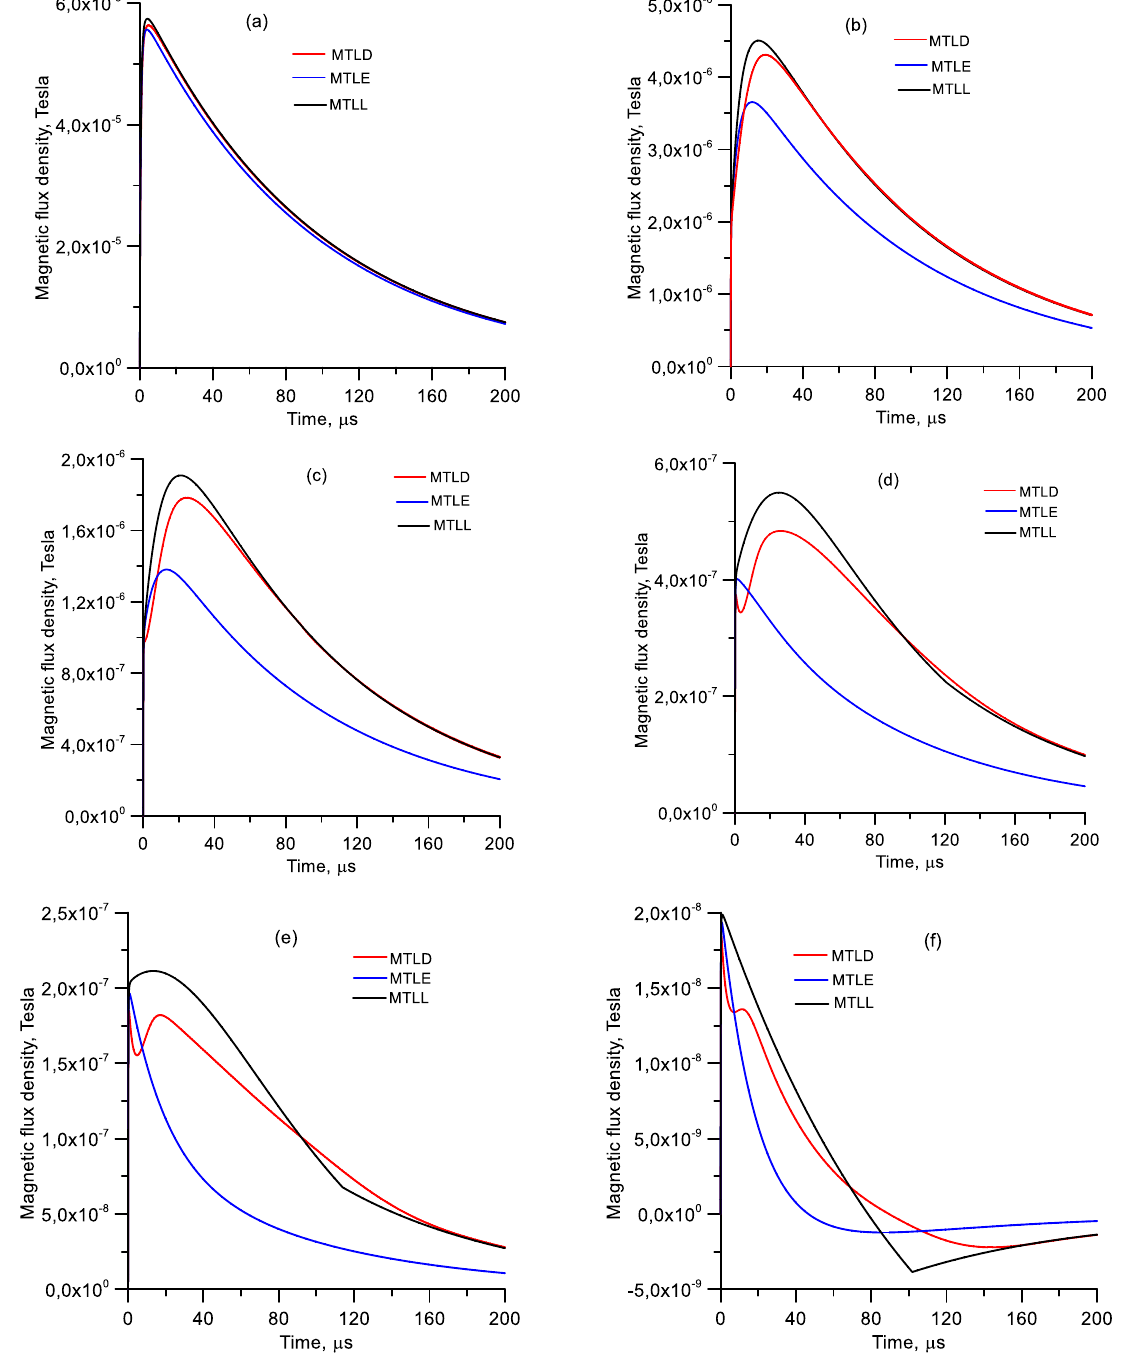
Figure 12. Magnetic field of first return strokes at different distances as predicted by the MTLD (with dispersion and decreasing velocity profile with λ v = 10 km), MTLE and MTLL models. ( a ) 50 m, ( b ) 1 km, ( c ) 2 km, ( d ) 5 km, ( e ) 10 km and ( f ) 100 km. In the MTLE model, λ = 2.0 km and, in the MTLL model, H = 10 km are used as model parameters. In the MTLE and MTLL models, the return stroke speed remains constant at 1.0 × 10 8 m/s.